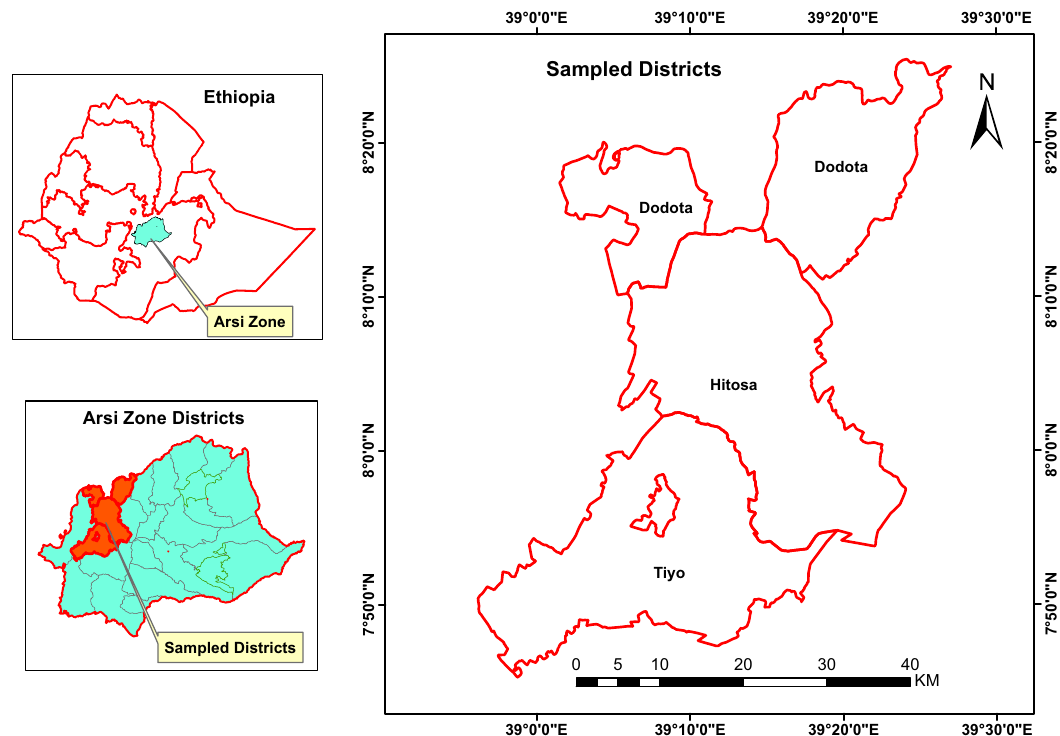
Fig. 2 Location map of the study area. Map of the study area showing location of Arsi zone (Beryl Green) in Ethiopia (White) and sampled districts Dodota, Hitosa and Tiyo (Fire Red) in Arsi zone (Beryl Green), as well as (White) in right side map. (Source of the data/shape fi le: Oromia Urban Plan Institute,